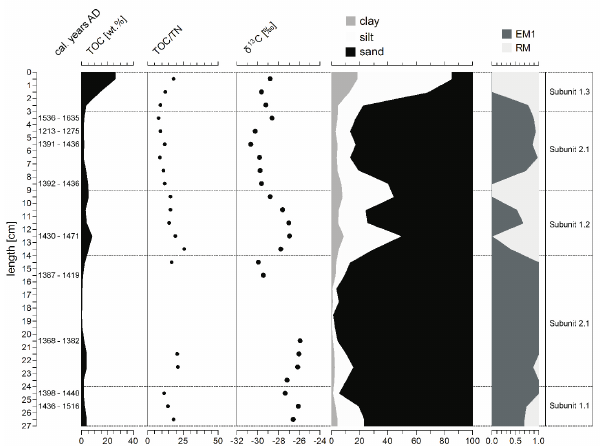
Fig. 5. Organic matter (TOC, TOC/TN, δ 13 C) and granulometric characteristics of Core C. The subunits present the classification of the investigated core as a result of the measured